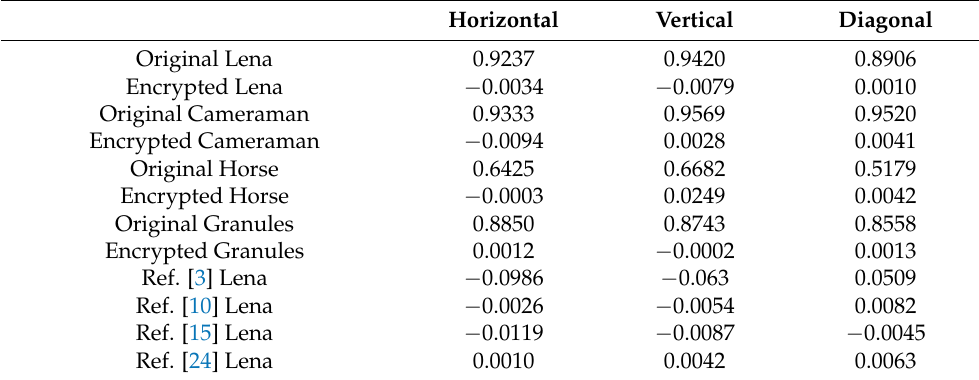
Table 2. Correlation coefficients analysis.